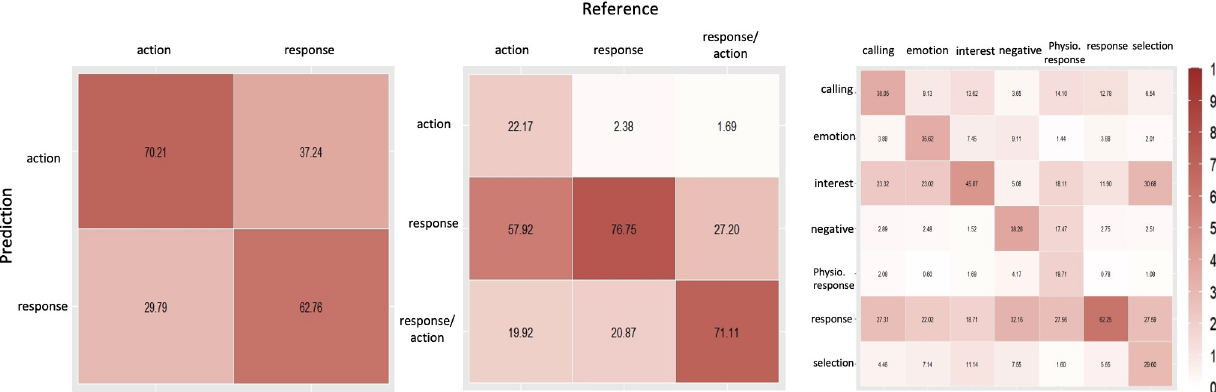
Fig 9. Confusion matrices showing the mean classification accuracy rates (%) in binary and multiple outcome